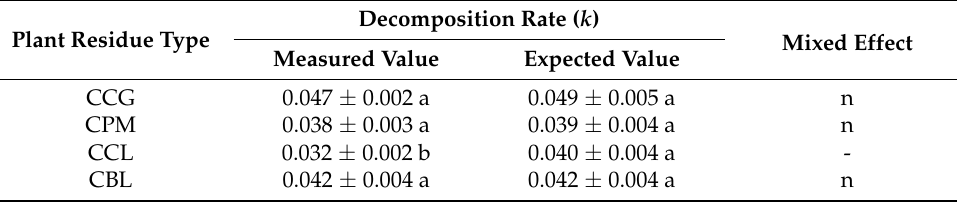
Table 4. Expected and measured decomposition rates of the mixed plant